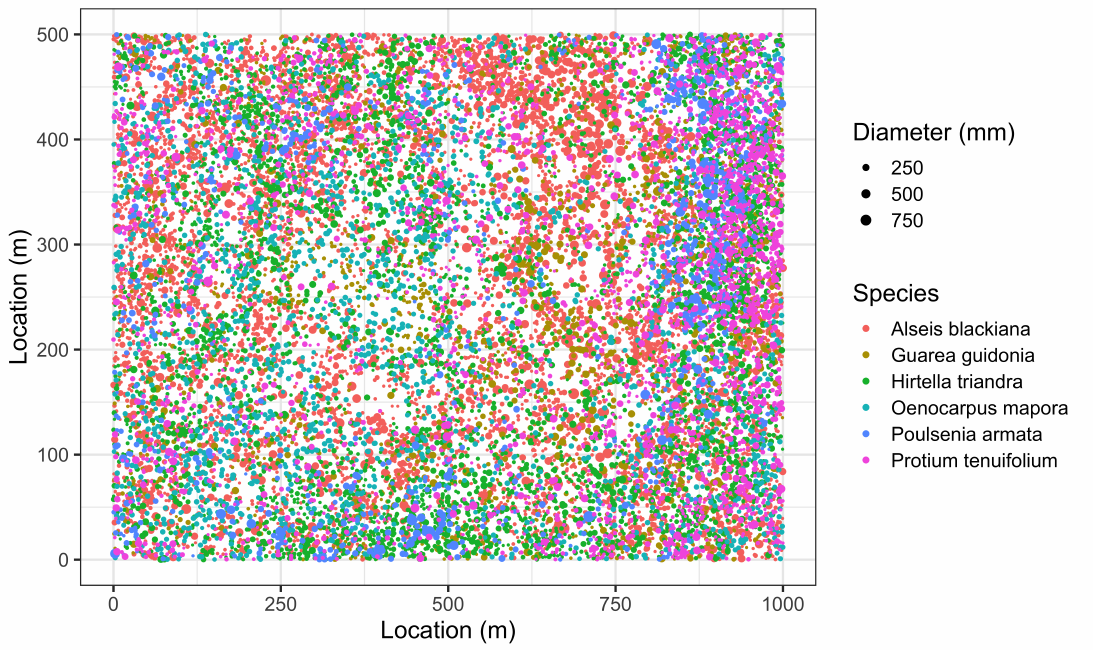
Figure 5. Distribution and size of the six species of trees growing in the 50-hectare plot at Barro Colorado Island, Panamá that we analyzed to assess the effect of sampling